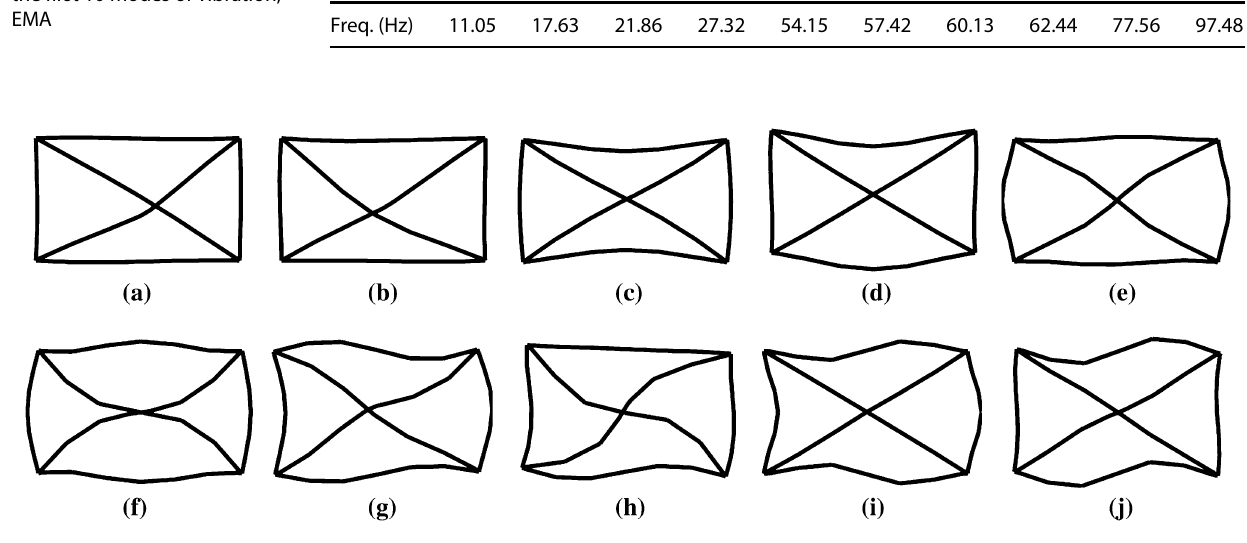
Fig. 14 Mode shapes of the a – j first-10th modes of vibration, EMA